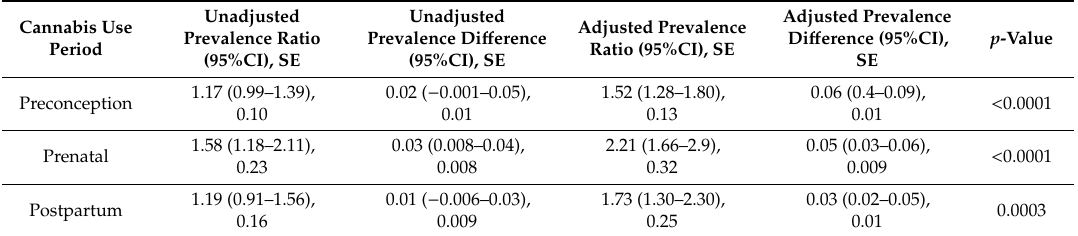
Table 3. Unadjusted and adjusted a prevalence ratio and prevalence di ff erence of cannabis use before, during, and after pregnancy by cannabis law status in